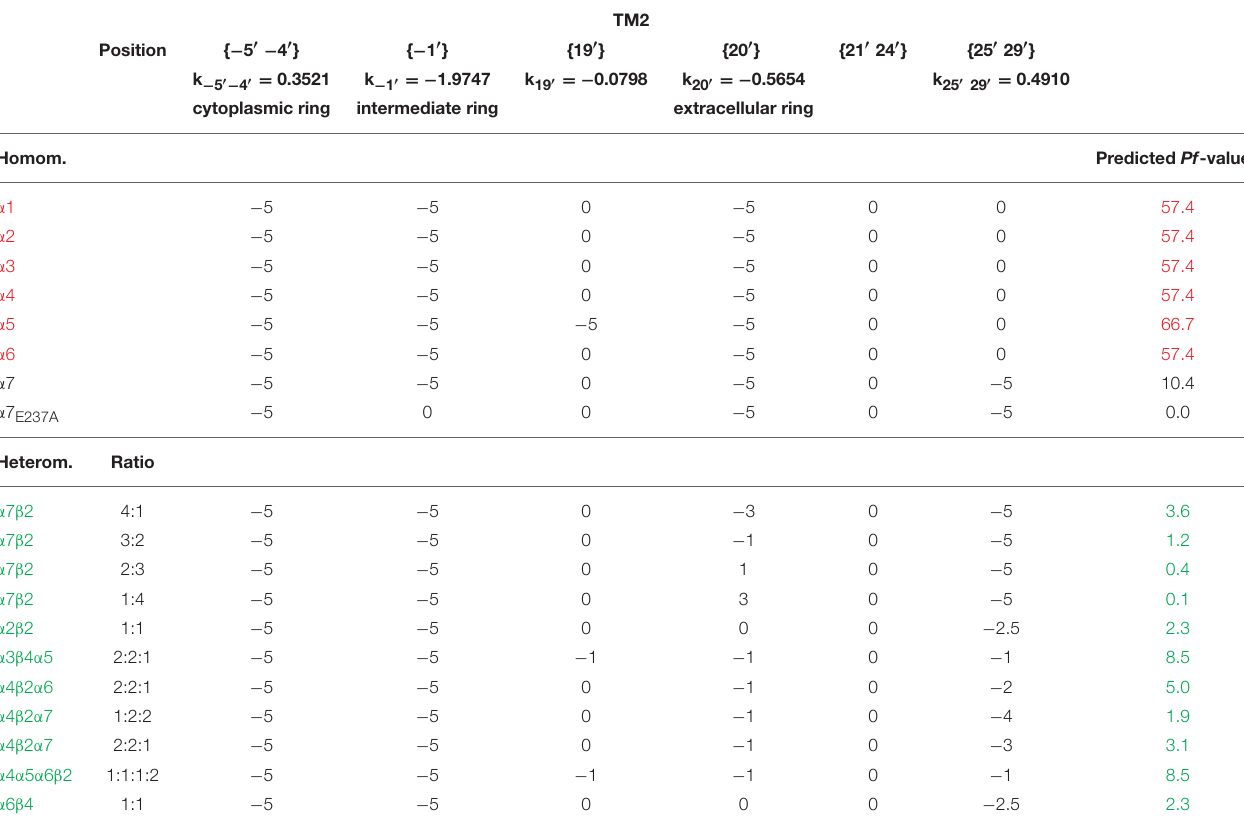
Non-existing homomeric nAChRs are indicated in red. Potential heteromeric nAChRs in green. Values for homomeric α 7 and α 7 E237A nAChRs are reported for comparison, in black. In brackets the positions of amino acid residues according to Miller (1989). Pf, fractional Ca 2+ current. Charge values are expressed in natural unit of electric charge (nuec). K i -values (expressed in nuec -1 ) indicate the multiplicative constants obtained by the fitting procedure described in the text, and used to predict the Pf-values.